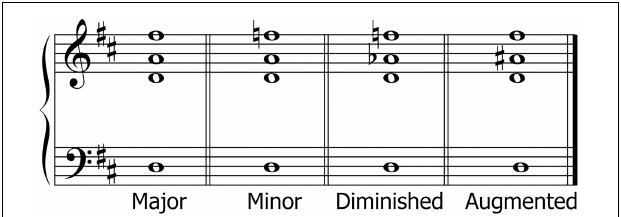
FIGURE 1 | Musical scores for the four different chords used in experiments 1 and